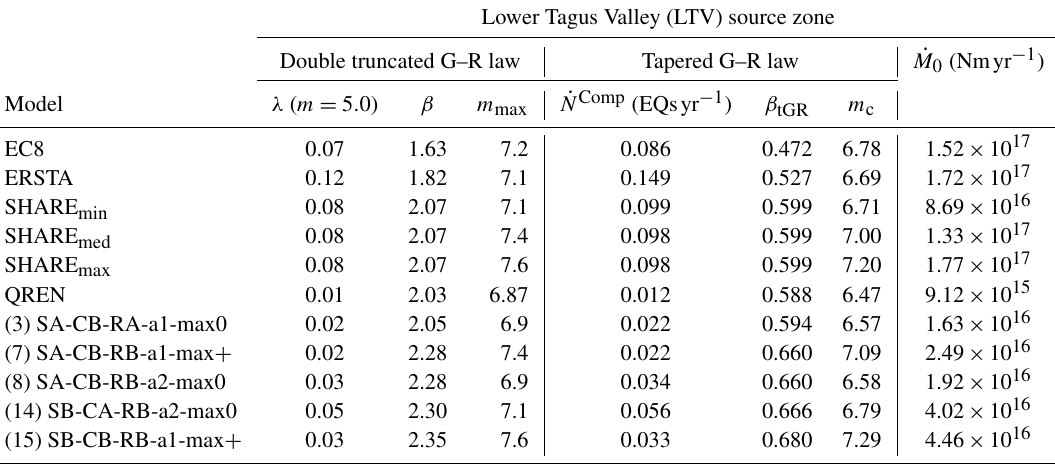
Table 6. Earthquake recurrence parameters for the Lower Tagus Valley source zones expressed as DTGR ( λ , β , m max ) and TGR ( ˙ N Comp in